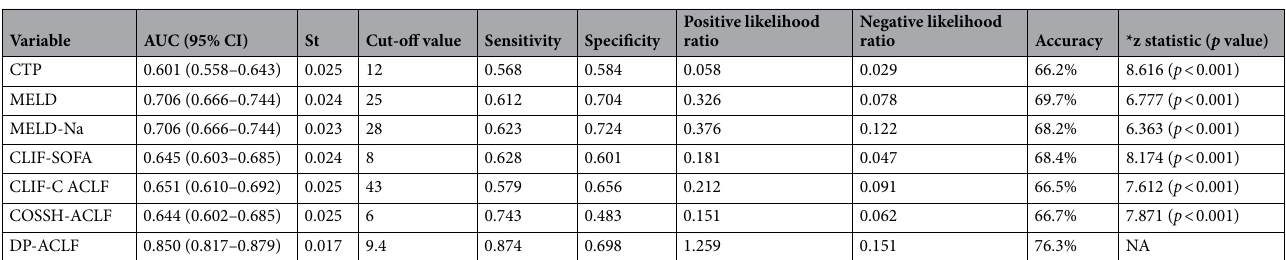
Table 5. Training group: ROC correlation analysis and comparison of DP-ACLF and other prognostic scores.